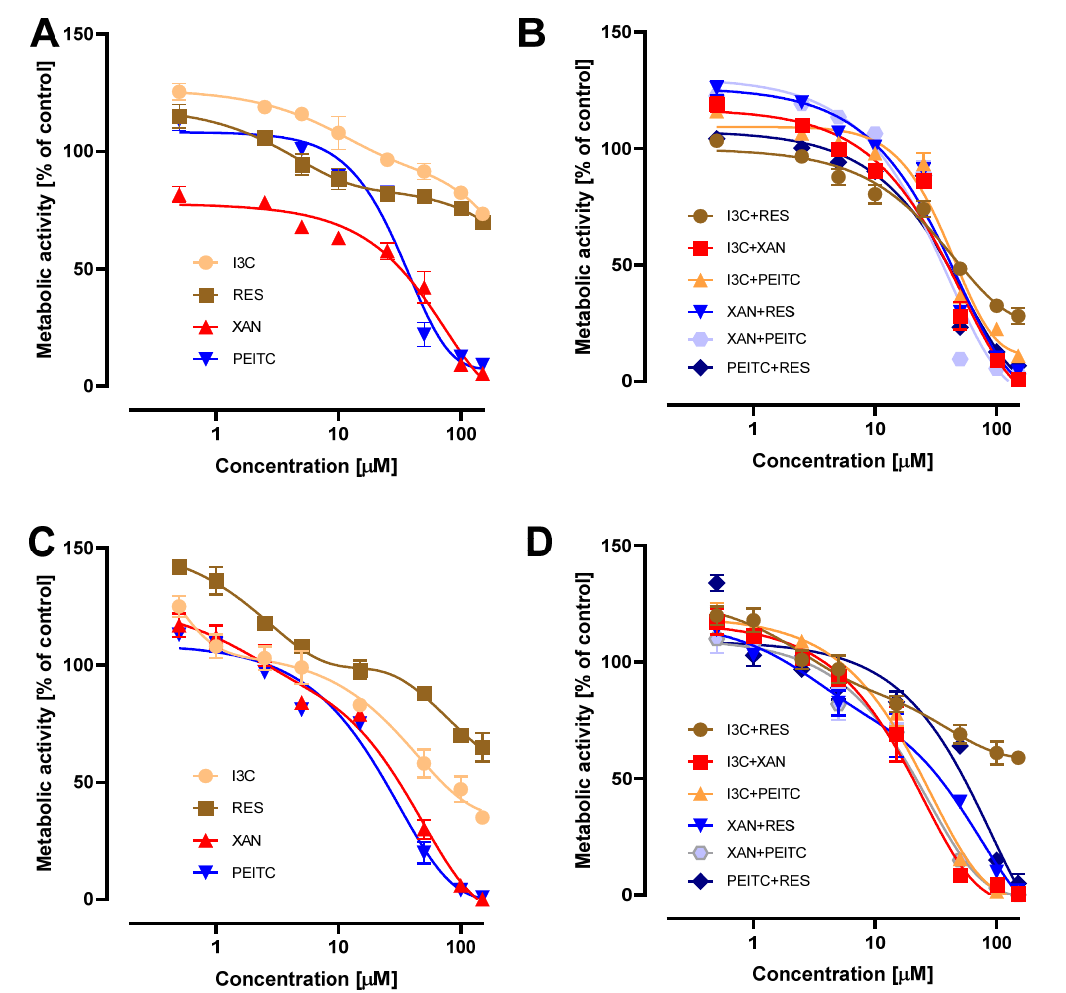
Figure 2. The impact of X, PEITC, RES, I3C, and their mixtures on cell viability of THLE-2 (panel A , B ) and HepG2 (panel C , D ) cells. Cell viability was estimated in comparison with vehicle control (100% viability). The values are shown as the mean ± SEM calculated from three independent ex- periments.